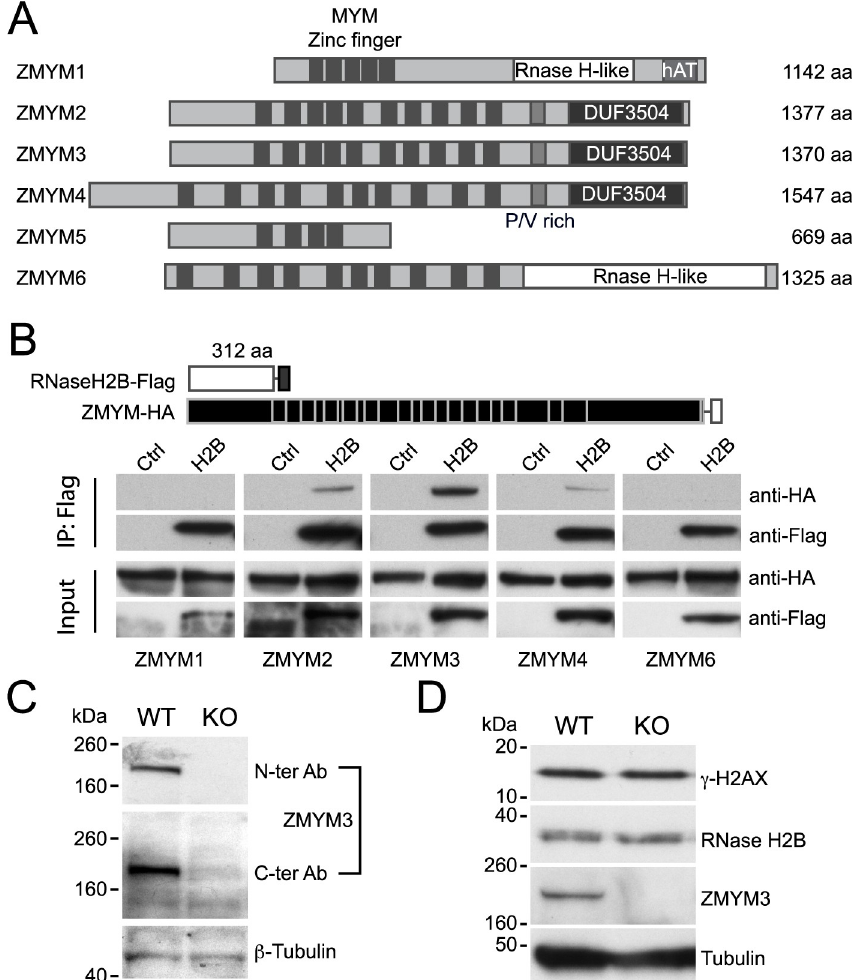
Fig 4. ZMYM3 and RNase H2B interaction is redundant with other ZMYM proteins. (A) Schematic representation of the conserved members of the human ZMYM protein family. Conserved domains are aligned based on homology. The MYM type zinc fingers are indicated as is the proline rich (PV) region and the domain of unknown function DUF3504. ZMYM 1 and 6 contain a domain with structural homology to the RNase H fold, but have no known RNase activity. (B) Pull down of transfected FLAG-tagged RNase H2B and HA-tagged human ZMYM proteins. Empty Flag- vector transfected HEK293T cells lysates are shown as control next to each co-expressing HA- tagged ZMYM 1, 2, 3, 4 and 6 lysates. Antibodies used were Mouse anti-FLAG M2 Peroxidase and Rat anti-HA Peroxidase. The input equals 3% of the total lysate. The same results were observed in three independent pull-downs. (C) Protein expression of mouse ZMYM3 in control and Zmym3 -/ ES cells. Two different monoclonal antibodies directed against the N terminus and C terminus of the protein were used to detect ZMYM3 in C57Bl/6 derived ES cells. Targeted Zmym3 -/ lacking Exon3 (KO) do not express either portion of the protein. The relative size of molecular standards is shown in kDa. β - tubulin levels are shown as control. (D) Expression of the damage response marker γ -H2AX is not affected in Zmym3 -/ ES cells. Protein lysates from the parental C57Bl/6 derived ES cells (WT) compared with the Zmym3 -/ ES cell lysates (KO). The relative size of molecular standards is shown in kDa. α -tubulin levels are shown as control. Antibodies used were Goat anti-ZMYM3, Mouse anti- γ -H2AX, Mouse anti- α -Tubulin, Rabbit anti-RNase H2B, Goat anti-Rabbit IgG Peroxidase, Donkey anti-Goat IgG Peroxidase and Goat anti-Mouse IgG Peroxidase. The same results in C and D were observed in three independent clones of targeted C57Bl/6-derived ES